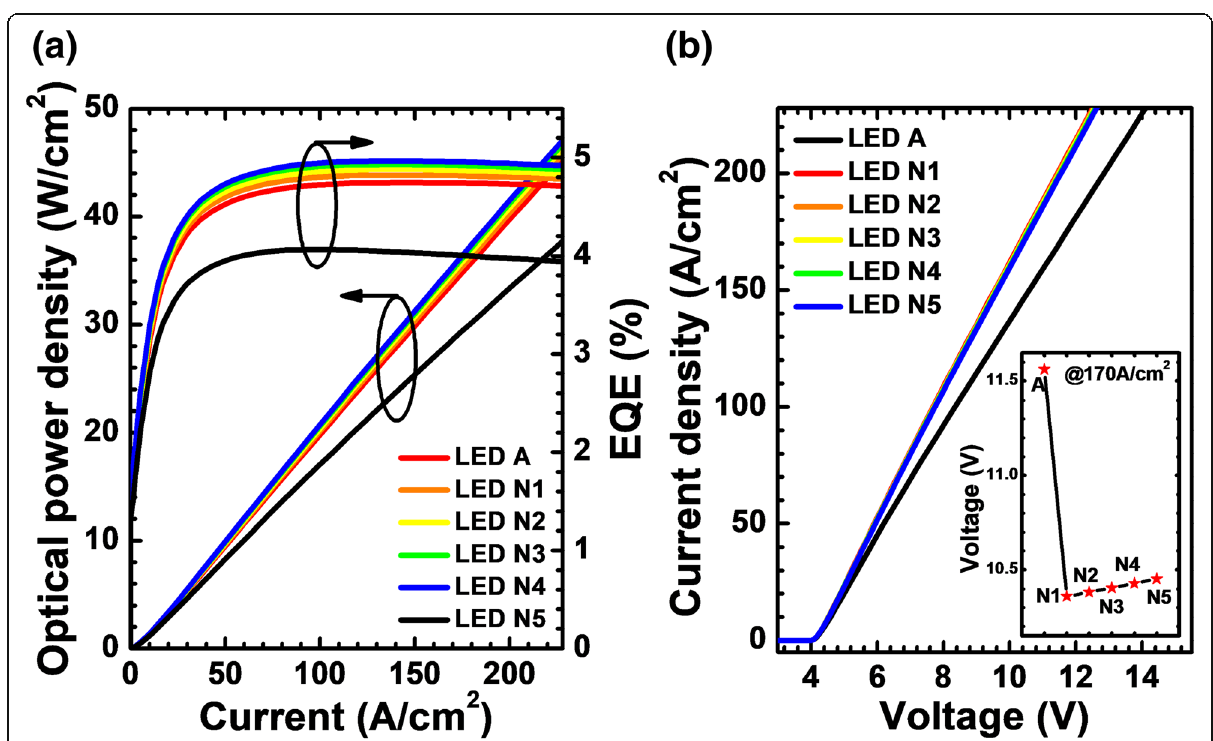
Fig. 16 a EQE and optical power density in terms of the injection current and b current-voltage characteristics for LEDs A and N i ( i = 1, 2, 3, 4, and 5). Inset: the forward voltages for LEDs A and N i ( i = 1, 2, 3, 4, and 5) when the current density is 170 A/cm